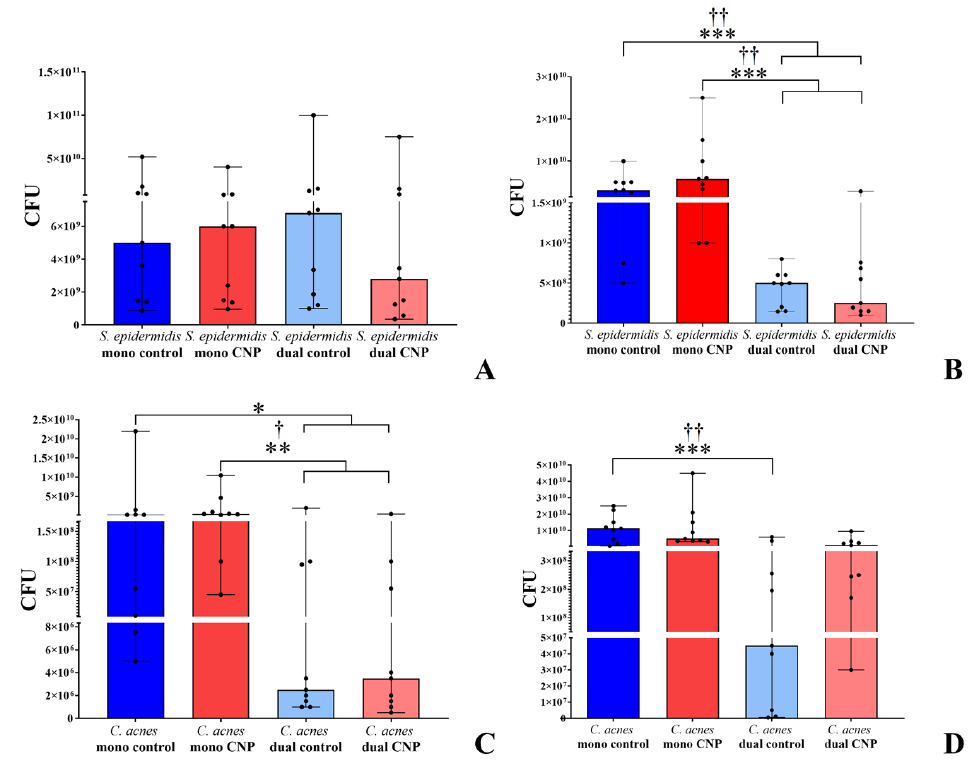
Figure 4. CFU counts in mono-species and dual-species biofilms of C. acnes and S. epidermidis . ( A ), CFU counts of S. epidermidis after 24 h of incubation; ( B ), CFU counts of S. epidermidis after 72 h; ( C ), CFU counts of C. acnes after 24 h of incubation; ( D ), CFU counts of C. acnes after 72 h of incubation; * represents p < 0.05; ** represents p < 0.01; *** represents p < 0.001. †† represents p < 0.005; † represents q < 0.05; absence of daggers represents q ˃ 0.05.